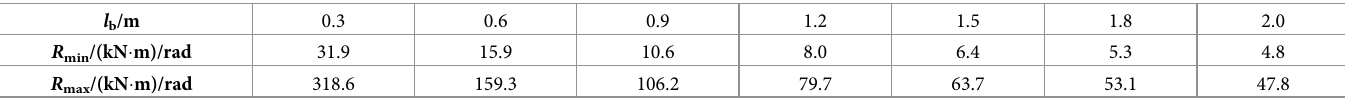
Table 6. Regional boundary of initial bending stiffness of semi-rigid joint under the positive